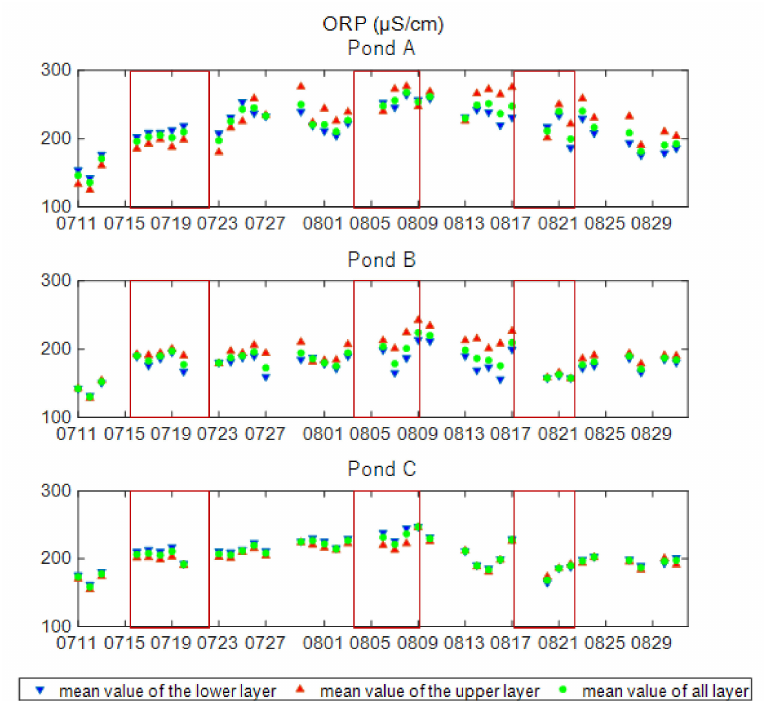
Figure 11. Mean ORP value for the lower layer, upper layer, and all